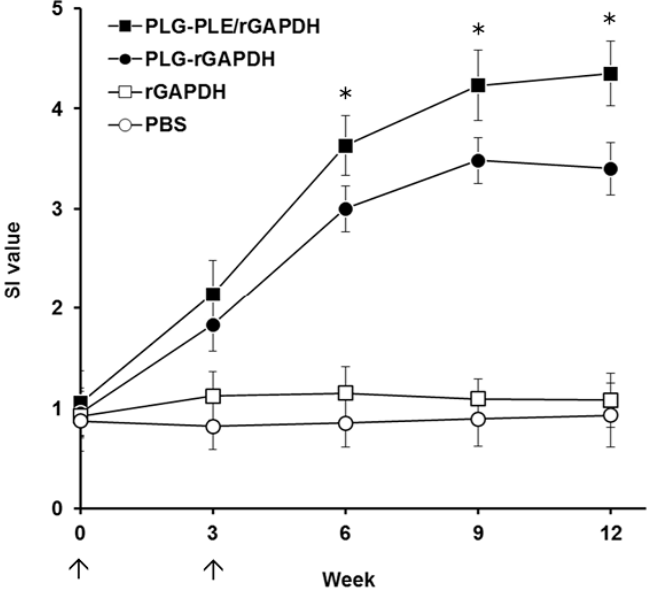
Figure 6. Proliferation responses against V. harveyi in immunized grouper. Four groups of grouper were intraperitoneally immunized twice (↑) with PLG-PLE/rGAPDH microparticles (■), PLG-rGAPDH microparticles (●), rGAPDH alone (□) or PBS (○). After immunization, V. harveyi lysate-stimulated head kidney lymphocytes were prepared from three fish per group every three weeks, and their subsequent proliferation responses were analyzed and expressed as stimulation index (SI) values. Results were presented as the mean of SI values ± SD. * p < 0.05 when comparing the PLG-PLE/rGAPDH group to the PLG-rGAPDH